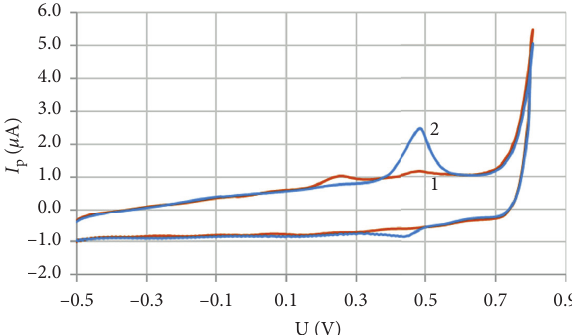
Figure 1: Cyclic voltammograms at sweep rate 0.1V.s − 1- , voltage